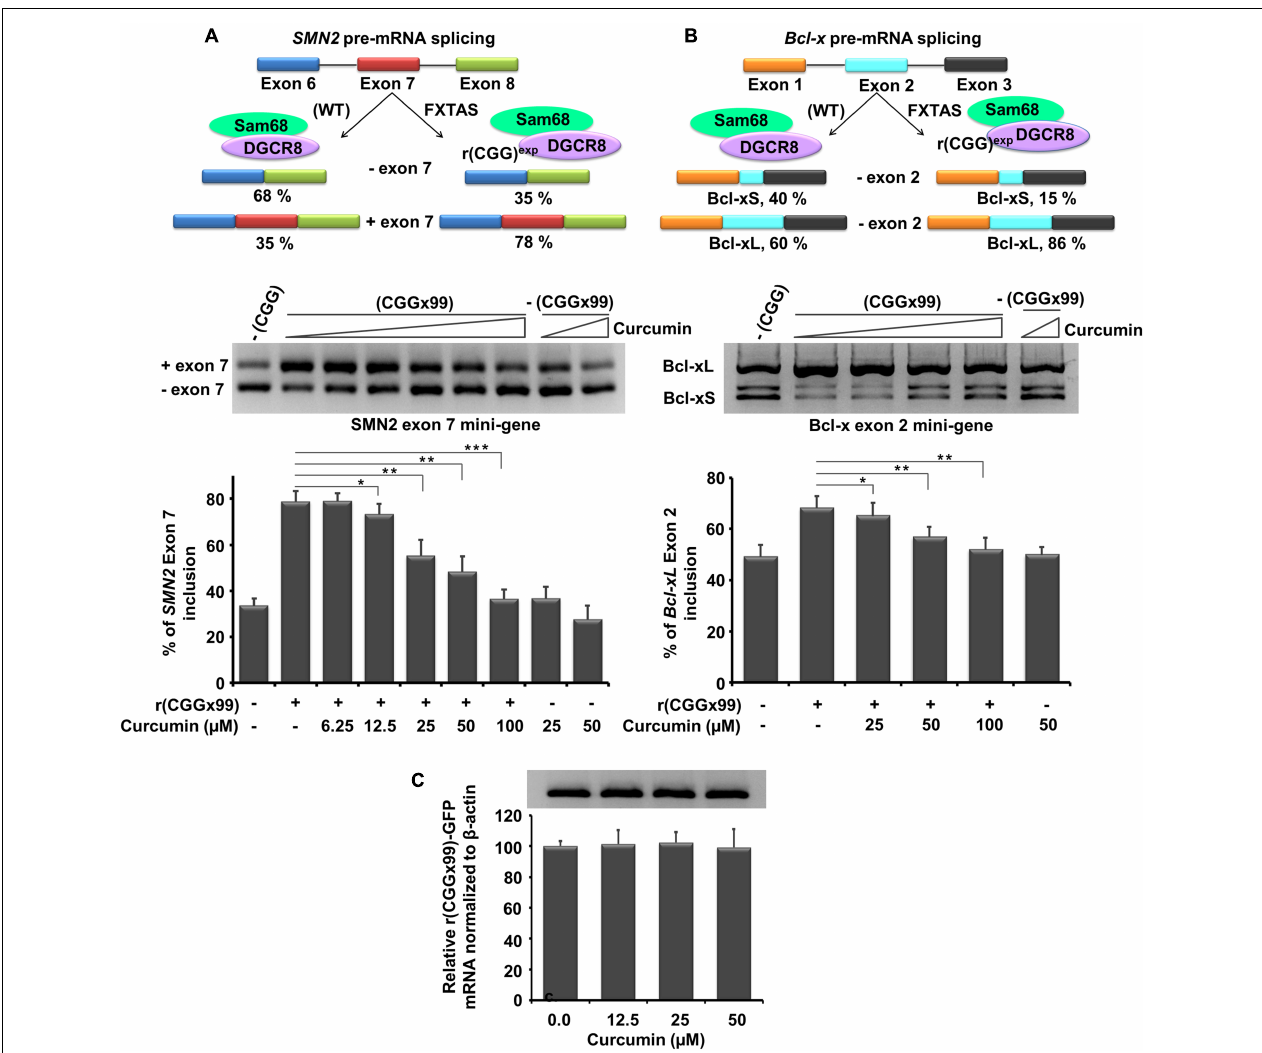
FIGURE 6 | In vitro potency of Curcumin in FXTAS cultured cell line. Curcumin treatment shown was to ameliorate FXTAS-associated pre-mRNA alternative splicing dysregulation of SMN2 and Bcl-x minigenes. Briefly, HEK cells were co-transfected SMN2 and Bcl-x mini gene with the plasmid containing CGG repeat (CGGx99). SMN2 splicing regulation is controlled by DGCR8 and Sam68 proteins. Upon sequestration and inactivation of these proteins the splicing of SMN2 is dysregulated [ (A) top, left]. FXTAS cellular model system treated with Curcumin, improvement of SMN2 splicing defects were restored to near to wild type at 100 µ M. Similar to SMN2, Bcl-x splicing is also controlled by DGCR8 and Sam68 and mis-splicing of Bcl-x caused due to presence of r(CGG) exp were ameliorated with Curcumin treatment in FXTAS cell models [ (B) top, right]. Importantly, Curcumin does not alter EGFP mRNA expression [ (C) bottom]. Standard deviation represented by Error bars. Statistical significance were calculated by One-way ANOVA where ** p < 0.01; * p < 0.05. Asterisk represent the statistical variation between control and